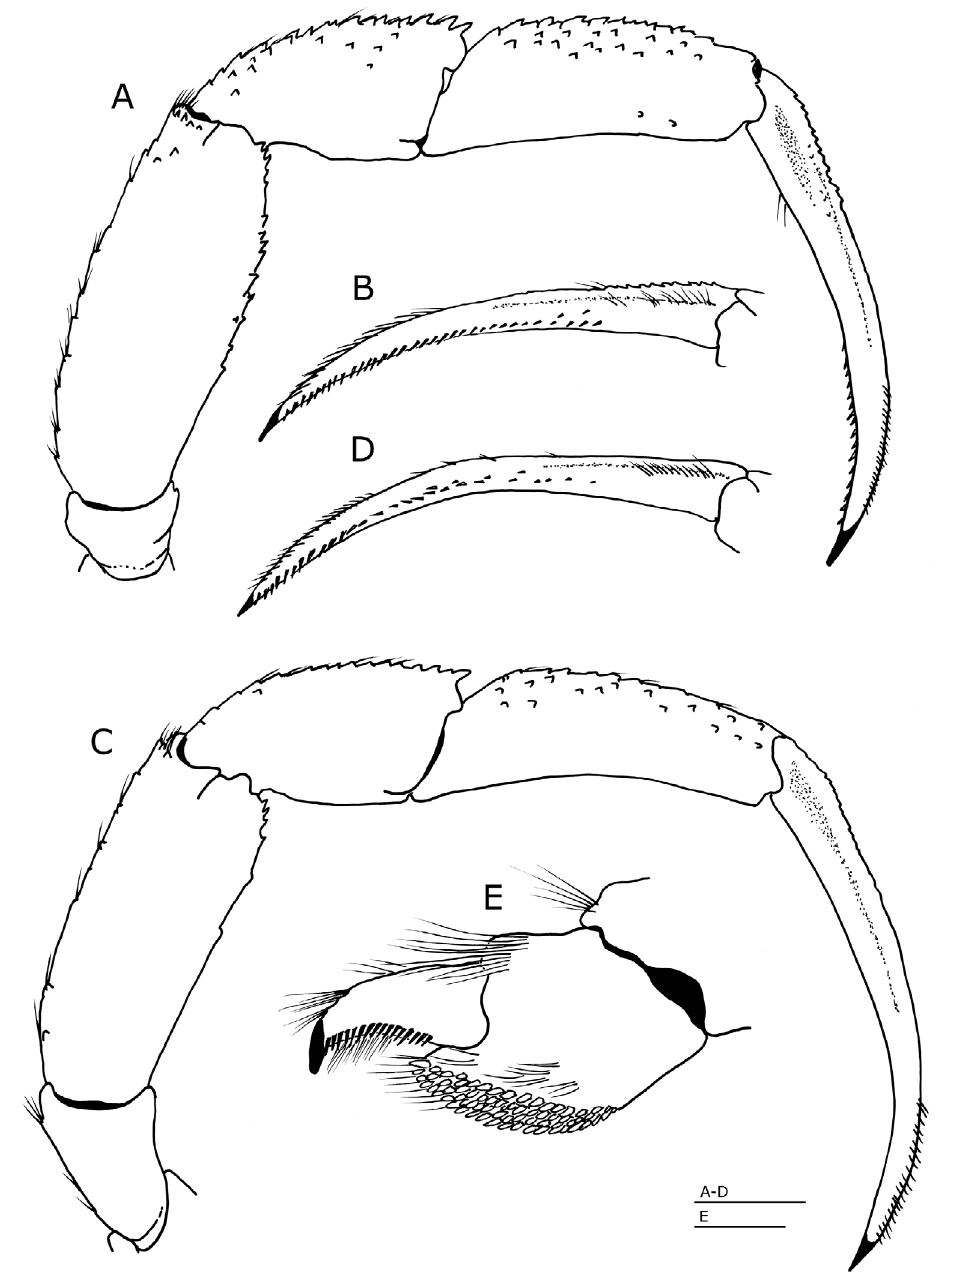
Figure 3. Pagurus politus (Smith, 1882), male lectotype 7.9 mm, USFC Albatross, sta 2823, northwestern Atlantic, Martha’s Vineyard, Massachusetts (USNM 16716): A , right second pereopod, lateral view; B , dactyl of same, mesial view; C , right third pereopod, lateral view; D , dactyl of same, mesial view; E , propodus and dactyl of left fourth pereopod, lateral view. Scales equal 5 mm (A–D) and 1 mm